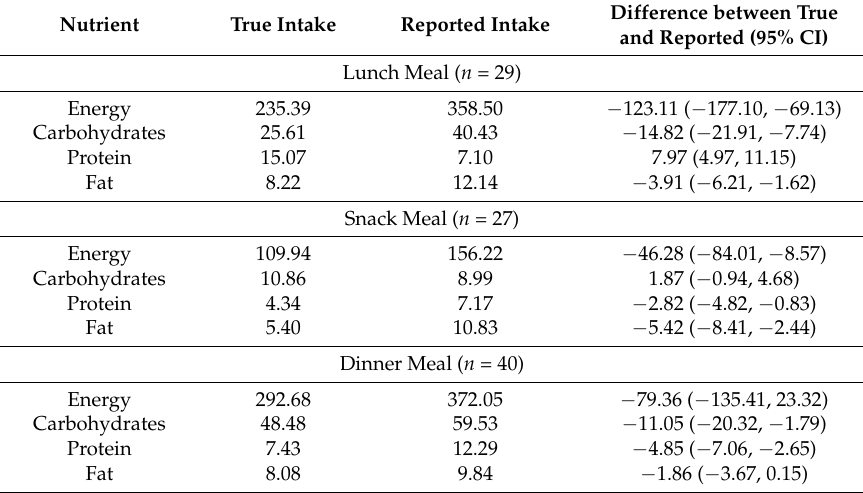
Table 4. Energy and macronutrient differences between true and reported intake during each meal occasion (lunch, snack, and dinner).